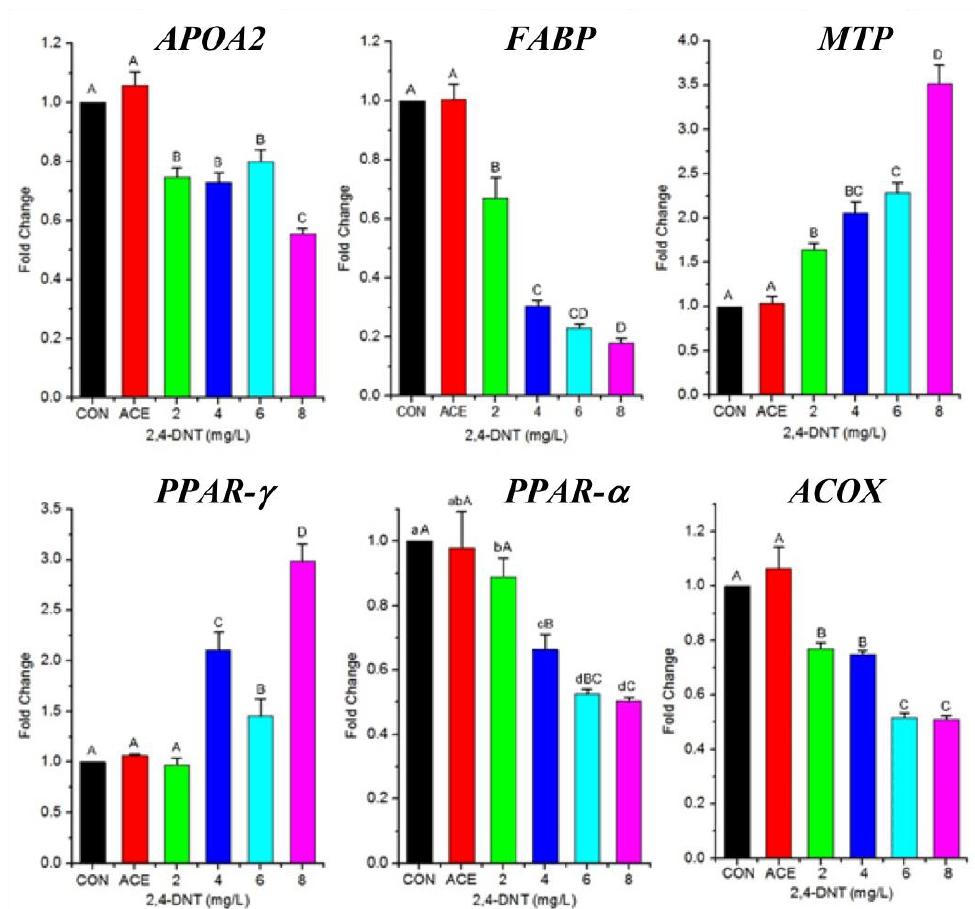
Figure 6. Relative mRNA expression levels of genes involved in lipid transport and metabolism in zebrafish exposed to 2,4-DNT at 5 dpf. Abbreviations: CON: control group; ACE: acetone group; APOA2: apolipoprotein a 2; FABP: fatty acid binding protein; MTP: microsomal triglyceride transfer protein; PPAR -γ : peroxisome proliferator-activated receptor γ; PPAR -α : peroxisome proliferator-activated receptor α; ACOX: acyl-CoA oxidase; unlike lower-case letters, superscripts for mean values are significantly different between the groups ( p < 0.05). Bars that do not share a common capital letter are significantly different between the treatments ( p < 0.01).